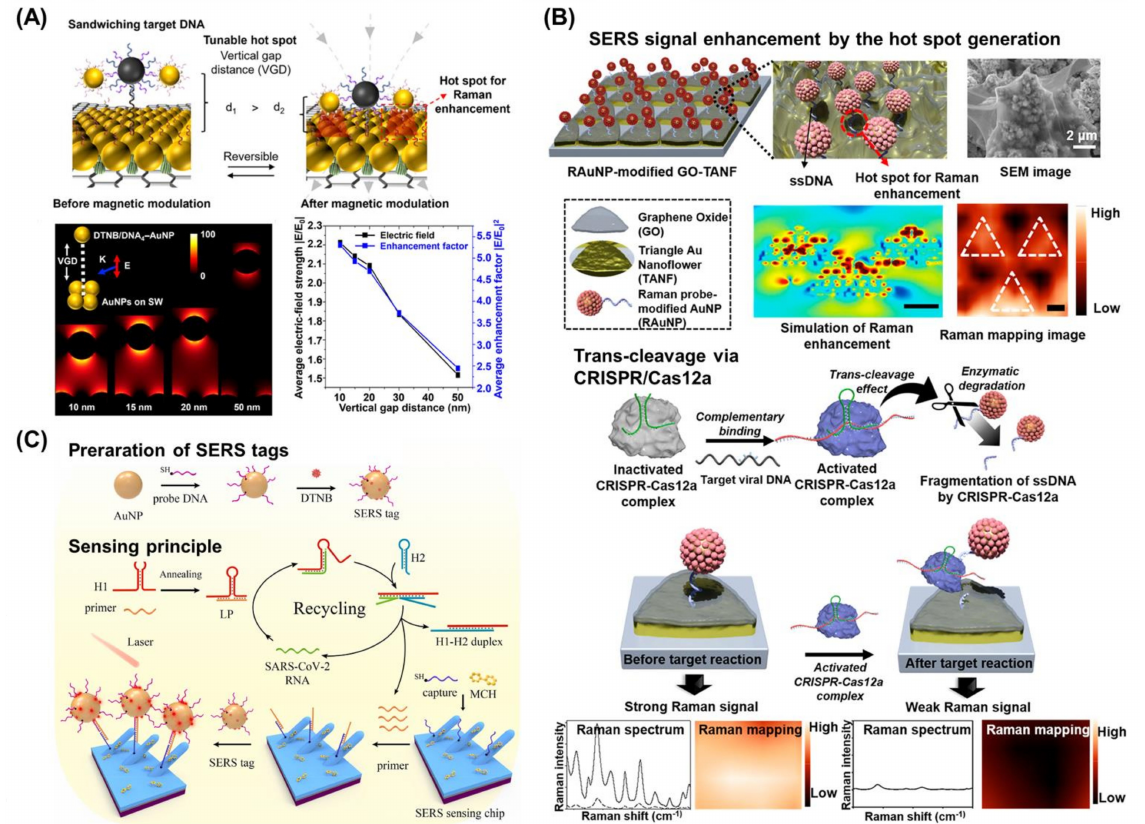
Figure 4. ( A ) Schematic diagram of Raman enhancement using magnetic modulation. Finite-Difference Time-Domain (FDTD) simulation results for change of vertical gap distance. From the calculation of electric field strength and enhancement factor, Au nanoparticle models showed ~1.5 fold and ~2.0 fold increments from 50 nm to 10 nm of vertical gap distance, respectively. Reprinted with permission from Ref. [18]. Copyright © 2022, American Chemical Society. ( B ) Fabricated platform composed of GO and periodic triangle nanoflower array with Raman probe modified Au nanoparticles enhanced the SERS signal by the generation of the hot spot, and after trans-cleavage via CRISPR/Cas12a in the presence of target nucleic acids, the Raman signal decreased since Raman probe modified Au nanoparticles were separated. Reprinted with permission from Ref. [104]. Copyright © 2021, American Chemical